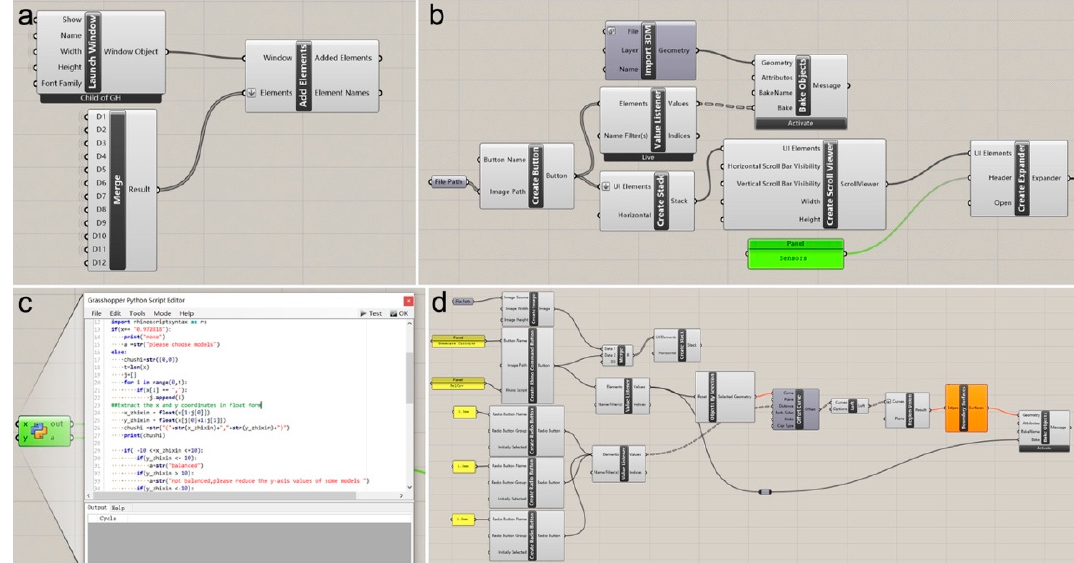
Figure 4. Software building: ( a ) fundamental framework built with Human UI; ( b ) grasshopper wiring diagram of the component library module; ( c ) code of the balance analysis module; and, ( d ) grasshopper wiring diagram of the circuit drawing module.